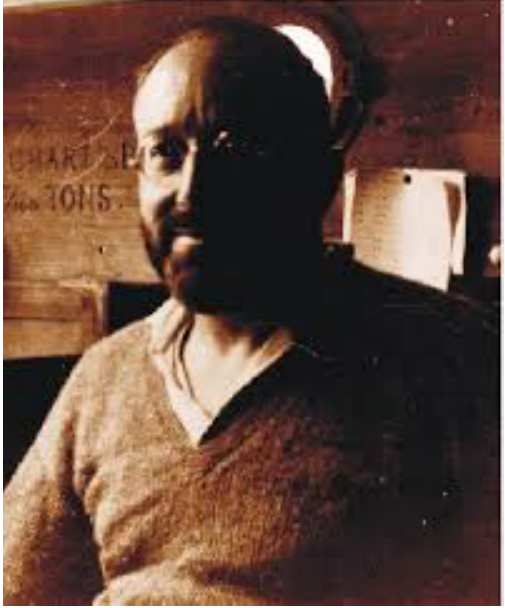
Figure 3. R.G. Collingwood on board Fleur de Lys in 1939 (Courtesy of Teresa